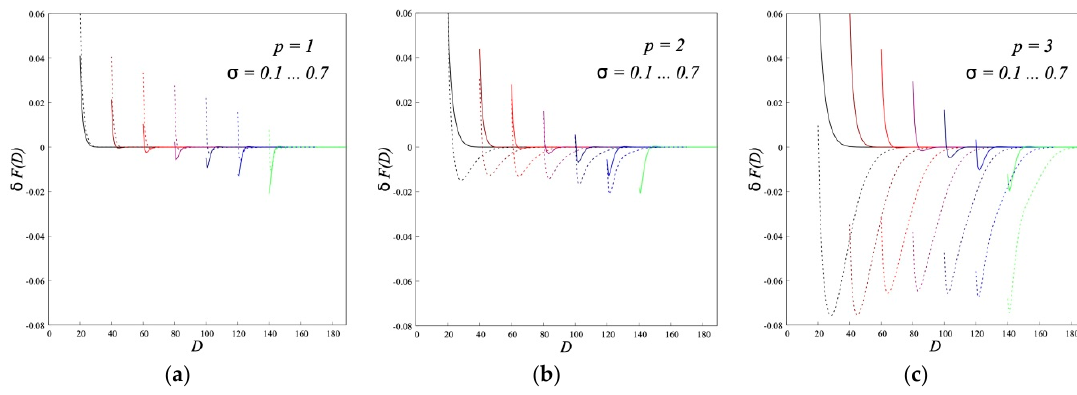
Figure 9. Interaction free energy δ F ( D ) between two brushes at different grafting density of chains at N = 200 and various Kuhn length: p = 1 ( a ), p = 2 ( b ) and p = 3 ( c ). The grafting density varies from σ = 0.1 to σ = 0.7 in 0.1 increments, that is indicated by di ff erent colors from left to right. Solid lines in the graphs correspond to non-dipole brushes ( τ = 0), dotted lines correspond to A-type brushes ( τ = 5).